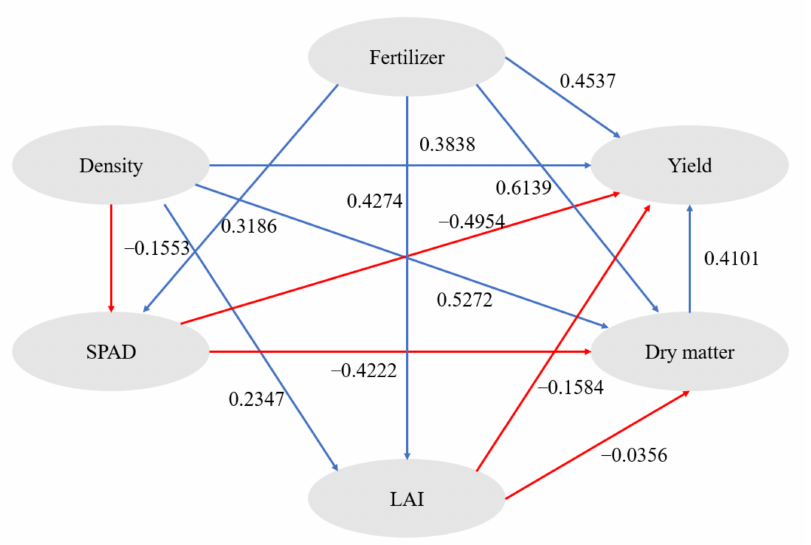
Figure 2. Results of PLSPM structural model. Each box represents an observed variable, with blue and red indicating positive and negative effects,